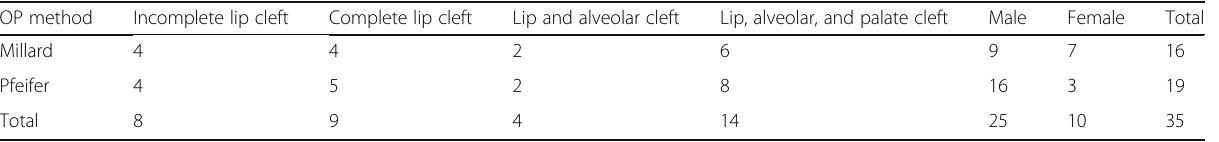
Table 1 Cleft Manifestation and operation procedure of the study Patients OP